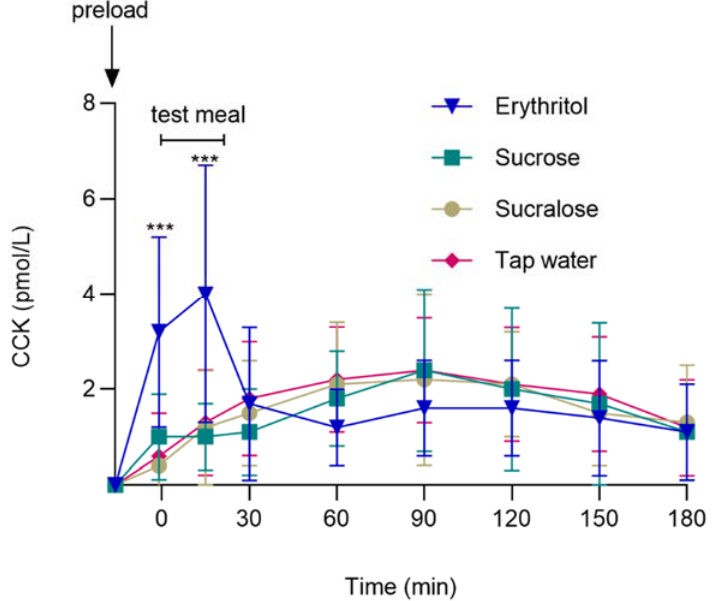
Figure 3. CCK concentrations after oral administration of either 50 g erythritol, 33.5 g sucrose, 0.0558 g sucralose, or tap water, and after the ad libitum test meal. Data are shown as mean ± SD, and baseline values are presented. Statistics: linear mixed models followed by planned contrasts with Holm correction for multiple testing. *** p Holm < 0.001 erythritol vs. sucrose, sucralose, and tap water. CCK, cholecystokinin. n = 20.